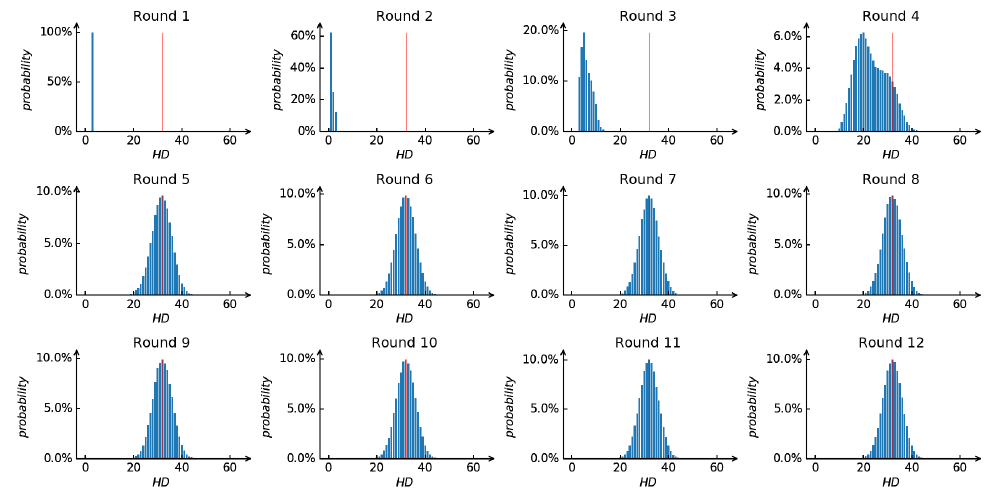
Figure 5. The diffusion of difference by the attack method with 12-bit changed (using 200,000 sets of